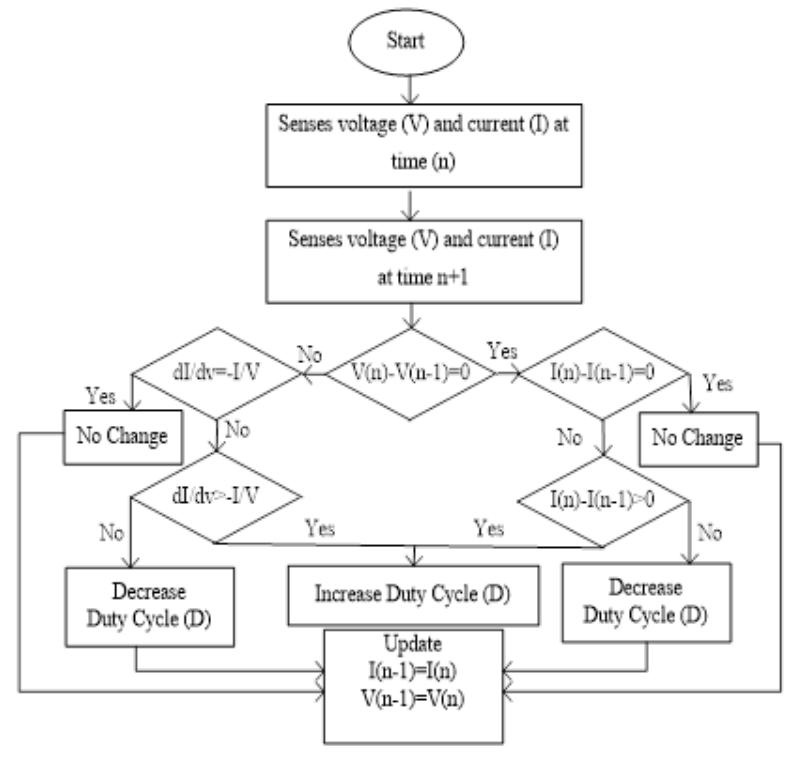
Figure 2. An algorithm for generation pulse at maximum power of solar